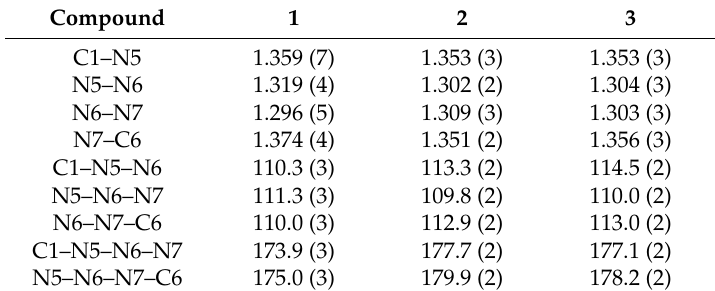
Table 3. Selected bond lengths, angles and torsions of the triazene bridge for 1 – 3 (Å, ˝ ).